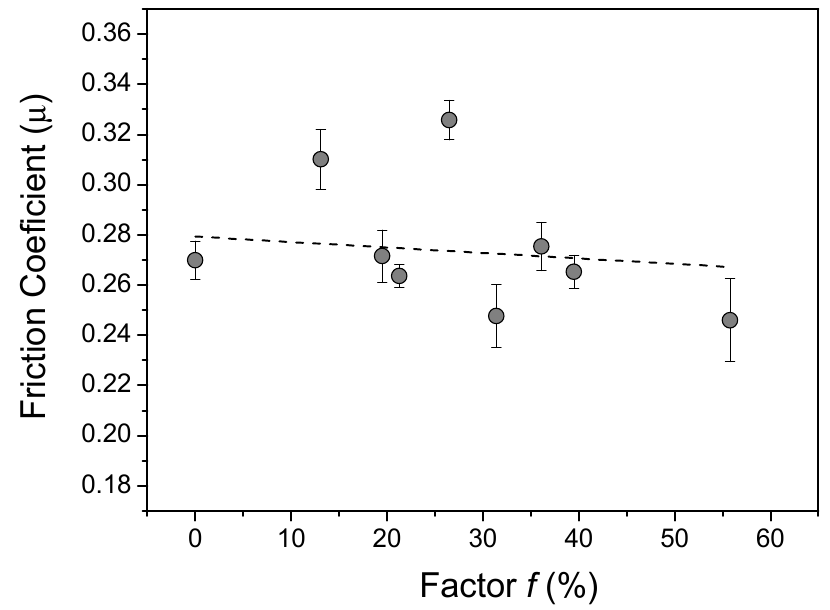
Figure 6. The relation between f (%) and µ for all manufactured tools in this work.